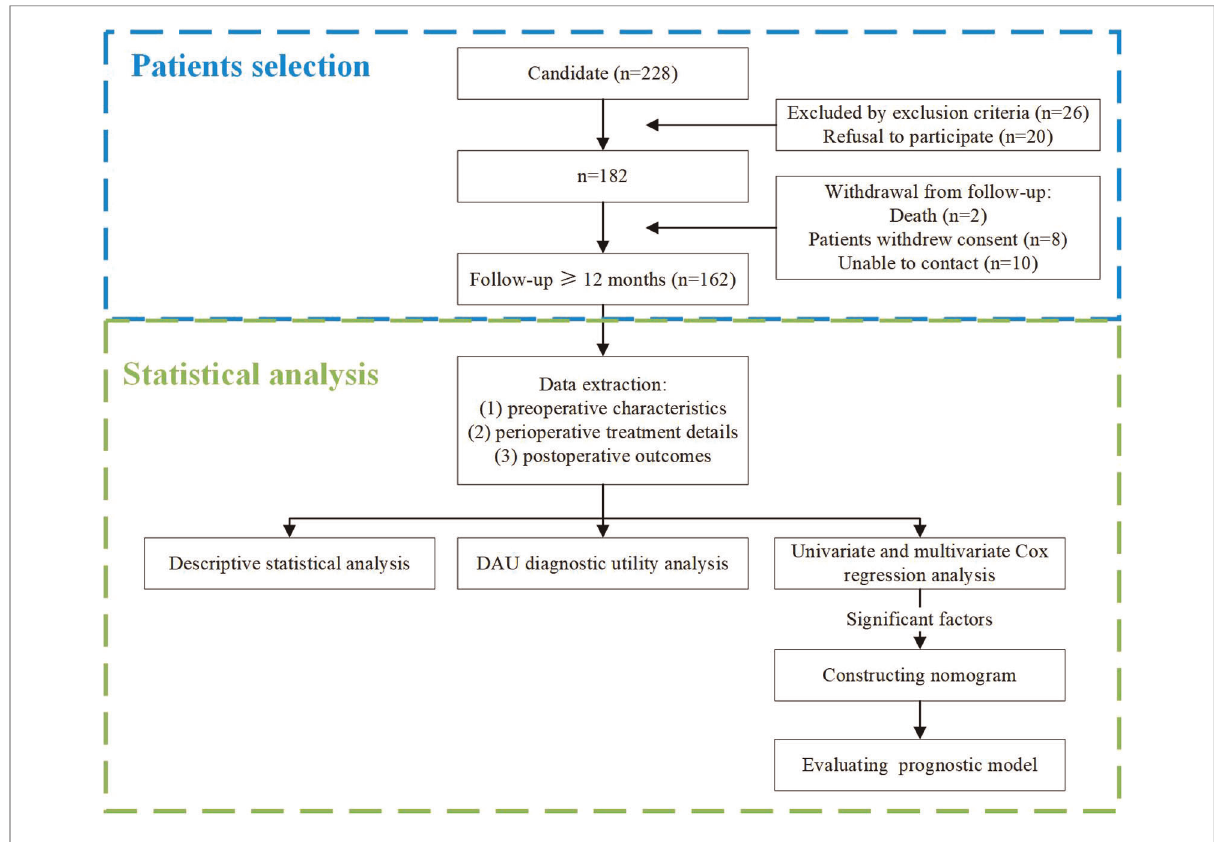
FIGURE 1 The fl ow chart of research